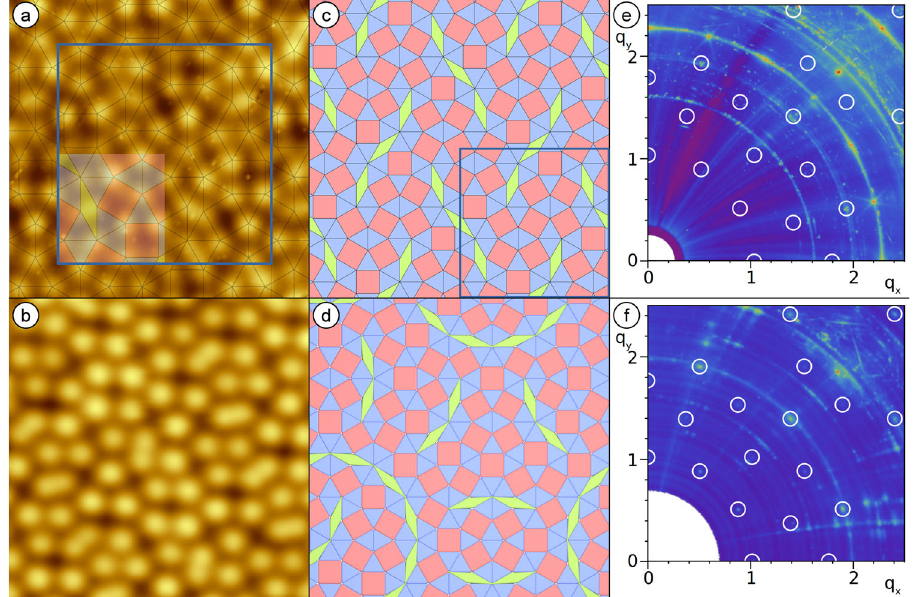
Fig. 1 | Comparison of the 48:18:6 approximant structure with the oxide qua- sicrystal. a The atomic-resolution STM image of the Sr-Ti-O approximant reveals 48protrusions in the unitcell(blue square). The semi-transparent tiling highlights the asymmetric unit. b The vertexatoms of the Ba-Ti-O oxidequasicrystalarrange in similar elementary tiles. c The approximant tiling is characterized by chains of three rhombuses, while pairs of rhombuses meeting in the center of a dodecagon dominate the QC tiling ( d ). In reciprocal space, the most intense spots of the